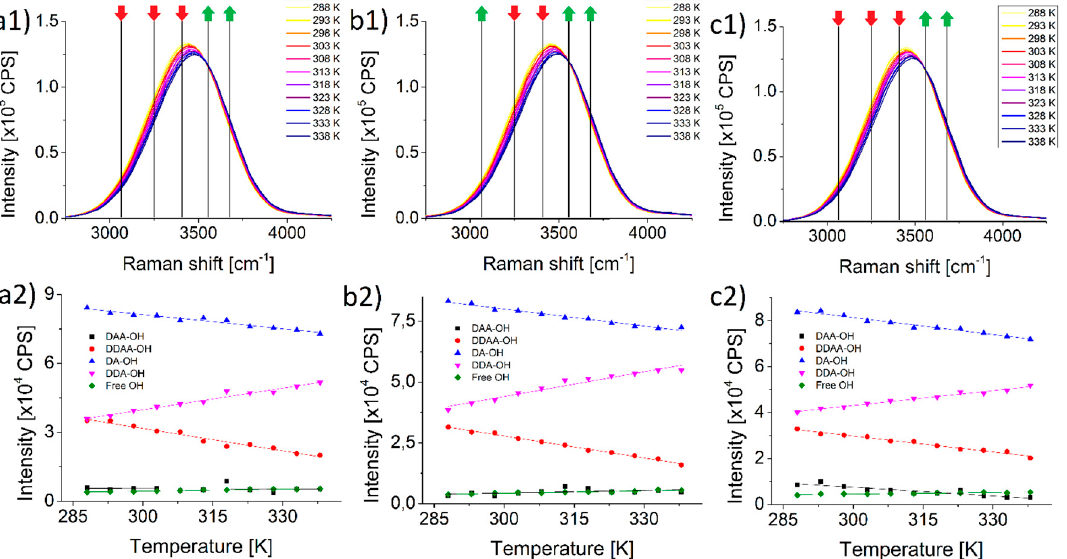
Figure 1. Temperature dependent Raman signals of ( a1 ) pure water, ( b1 ) 100 mM aqueous KClO 4 and ( c1 ) 100 mM aqueous NaClO 4 solutions. Changes of the amplitudes of Gaussians used to superpose the Raman spectra plotted against temper- ature ( a2 , b2 , c2 ). Red and green arrows indicate the decrease and increase in the amplitude of the respective deconvoluted Gaussians caused by increasing temperature.